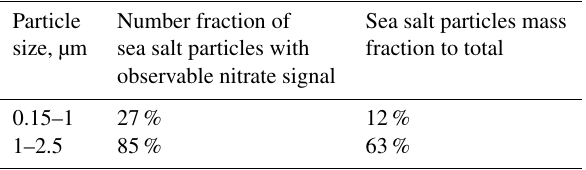
Table 1. Number fraction of sea salt particles with observable ni- trate signals and mass fraction of sea salt particles to total mass in two size ranges, 0.15–1 and 1–2.5µm. Sea salt particles are iden- tified as Na + -rich particles without crustal elements. The number fraction was determined directly from the PALMS data and the mass fraction was calculated based on the number fractions and size dis- tributions, assuming dry particle densities.